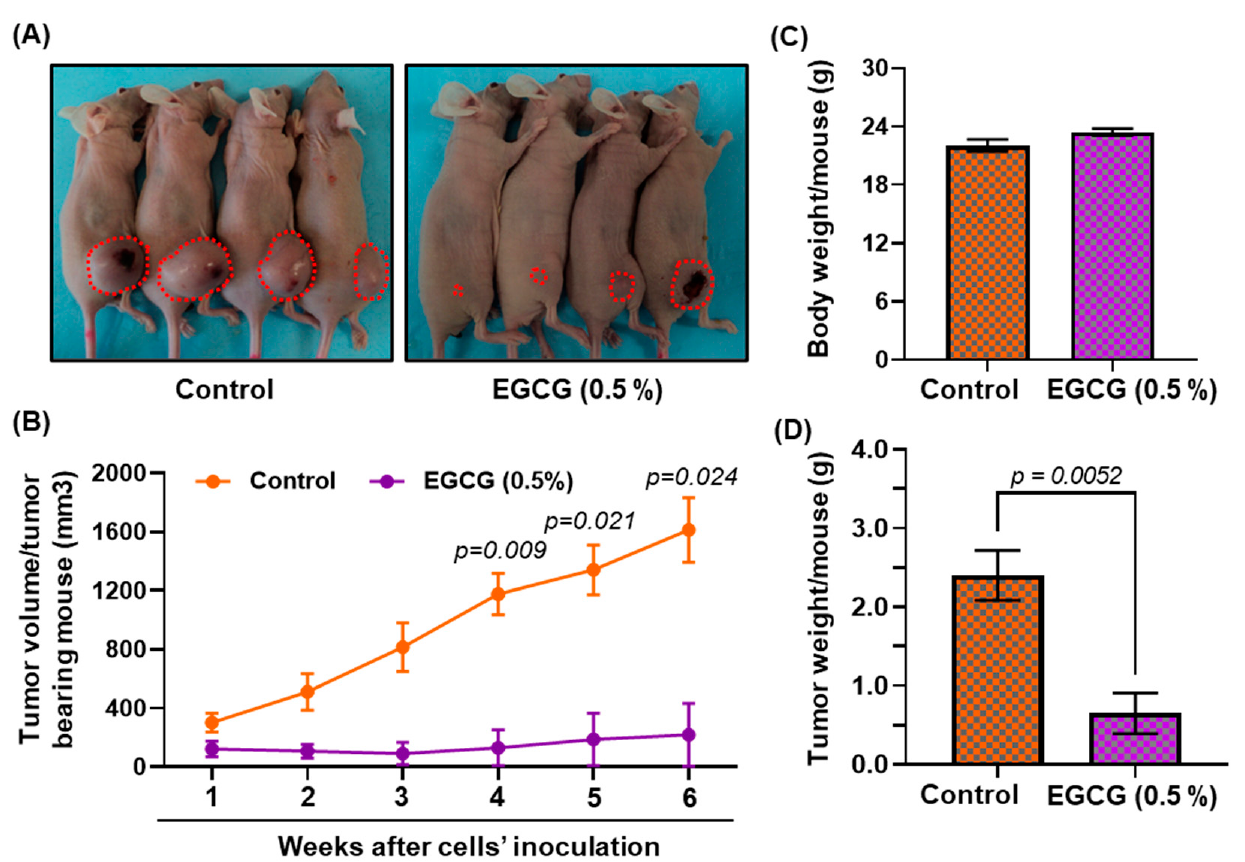
Figure 6. Dietary administration of EGCG inhibits the tumor growth of FaDu tumor xenograft in BALB/c nude mice. Mice were inoculated subcutaneously with 2 × 10 6 cells (FaDu) on the right flank. Dietary administration of EGCG started one week before tumor cell inoculation. Representation of